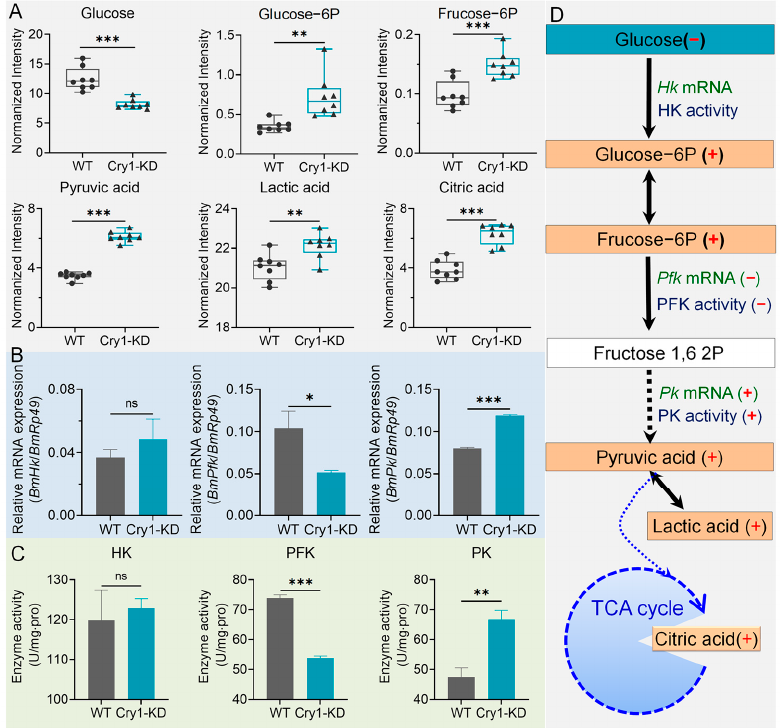
Figure 6. Effect of BmCry1 knockdown on glucose metabolism in BmN cells. ( A ) Changes in the contents of main substrates and products associated with glucose metabolism are based on metab-